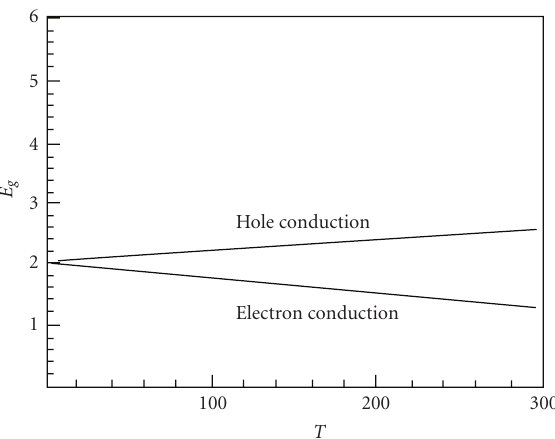
Figure 17: Energy gap E g ( T ) of the n-type (or p-type) extrinsic semiconductor is shown for electron conduction (or hole conduc- tion) where the energy gap E g = 2eV, t = 0 . 1eV, N c = P v = 10 9 , and n = 10 6 are used,